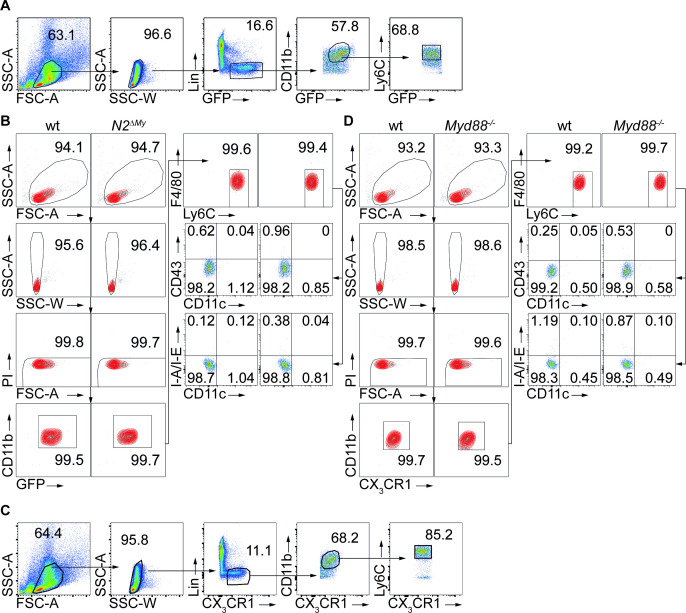
Strategy of monocyte isolation from mouse bone marrow.(A) Sorting strategy of BM Ly6Chi monocytes from CX3CR1-GFP expressing (GFP+) wt or N2ΔMy mice used for in vitro culture experiments in Figure 1, or for adoptive transfer in Figure 2 and Figure 5. (B) Expression of CD11b, Ly6C, CX3CR1, F4/80, CD11c, CD43 and I-A/I-E, and purity of the cells sorted for in vitro culture (Figure 1) or adoptive transfer experiments Figure 2 and Figure 5, respectively. (C) Sorting strategy for isolation of BM Ly6Chi monocytes from wt or Myd88-/- mice used for in vitro culture (Figure 1) or adoptive transfer experiments (Figure 2). CX3CR1 depicts staining with anti-CX3CR1 antibody. (D) Expression of CD11b, Ly6C, CX3CR1, F4/80, CD11c, CD43 and I-A/I-E, and purity of wt or Myd88-/- cells sorted for in vitro culture (Figure 1) or adoptive transfer experiments Figure 2 and Figure 5 respectively.